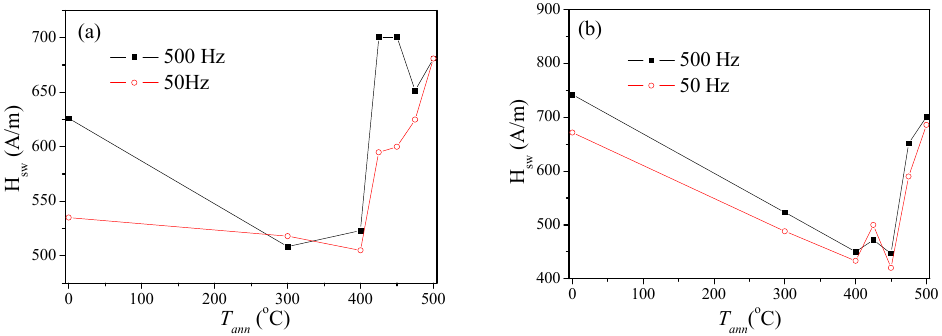
Figure 12. Dependence of the switching field on the annealing temperature of samples with ρ = 0.41 ( a ) and ρ = 0.6 ( b ) measured at f = 50 and 500 Hz. Reproduced from reference [70], Figure 5.